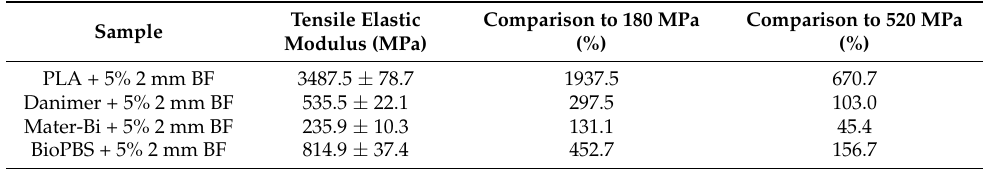
Table 11. Tensile elastic modulus comparison of the 1st generation compounds with the reference values of LDPE (180 and 520 MPa).